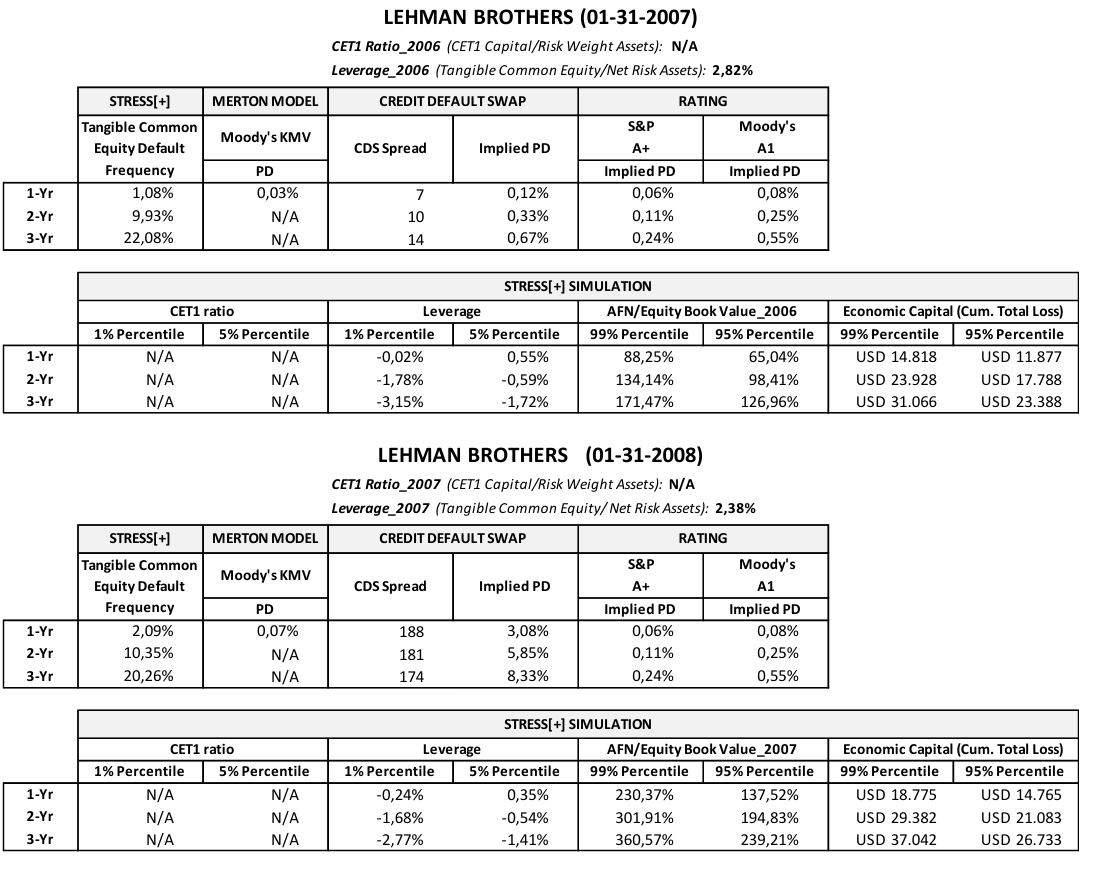
Figure A11. Backtesting comparative analysis: Lehman Brothers. (Source of CDS, KMV data, rating: Bloomberg, Moody’s KMV, Standard & Poor’s ).